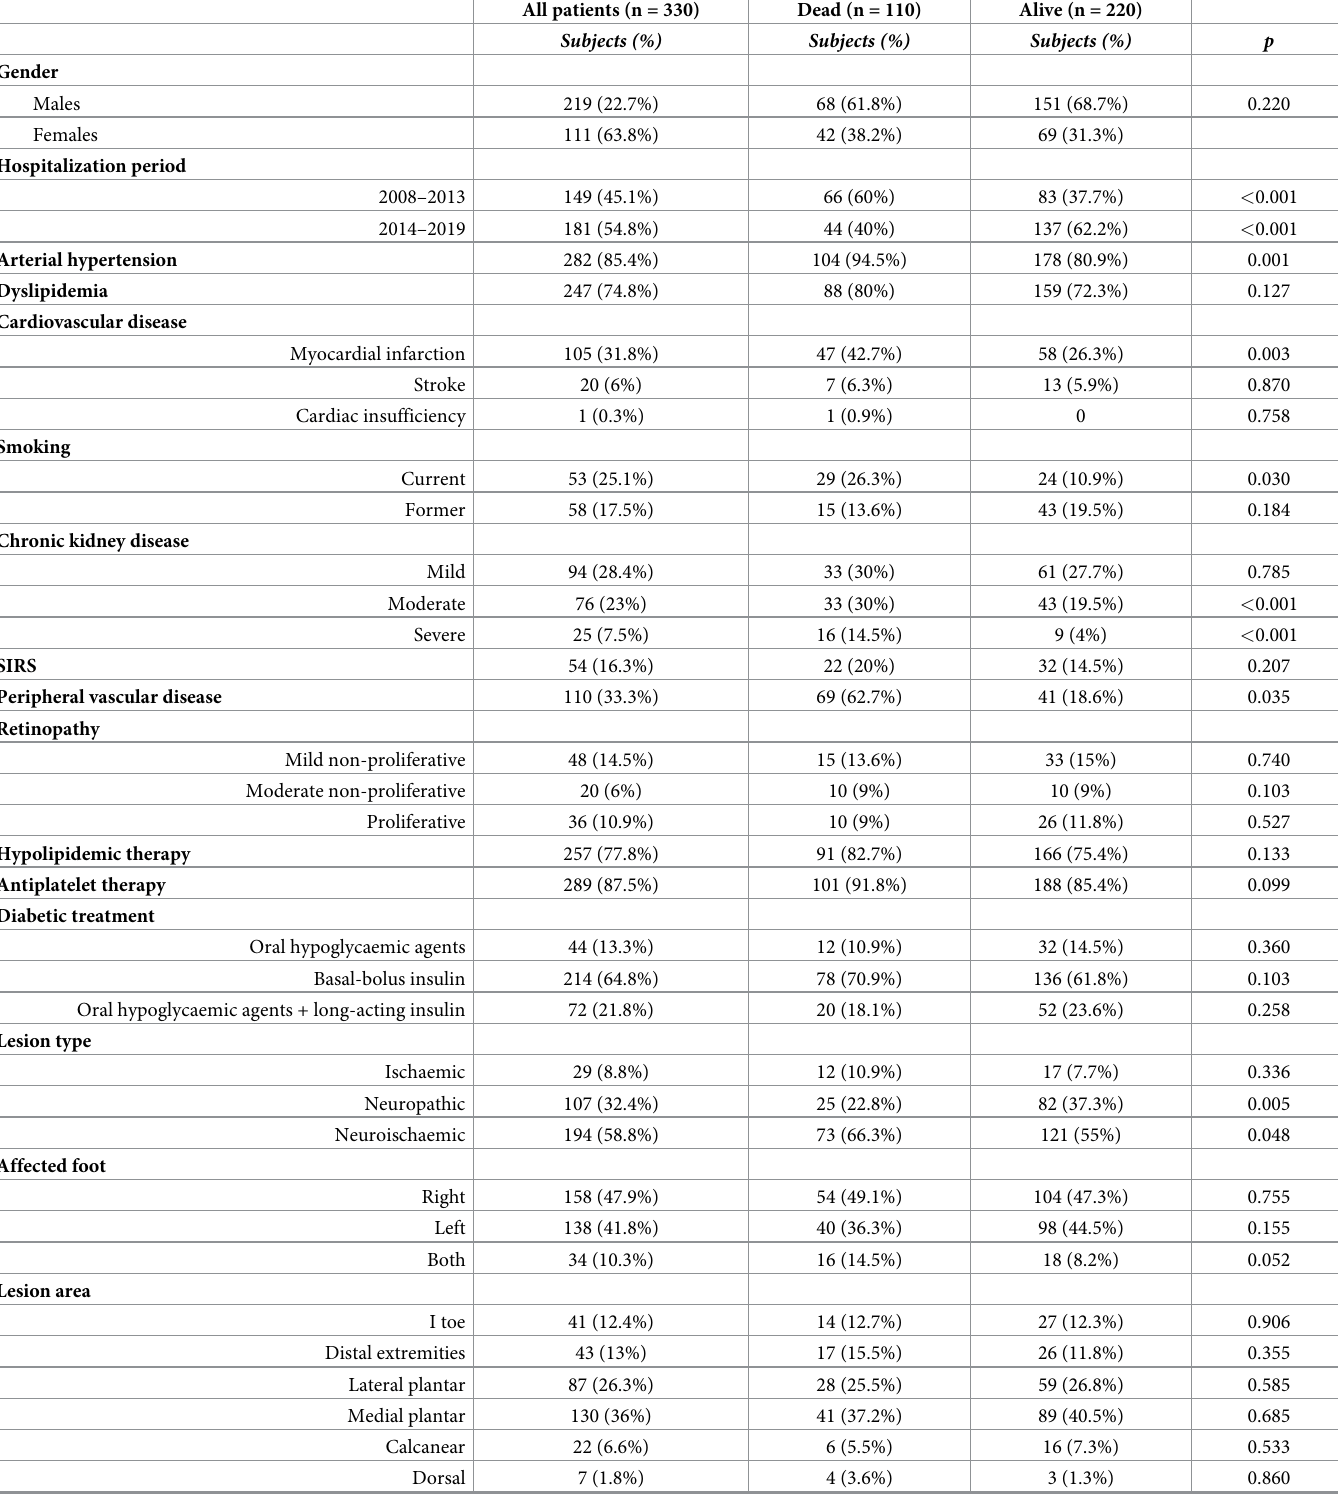
Table 1. General characteristics of all patients with diabetic foot